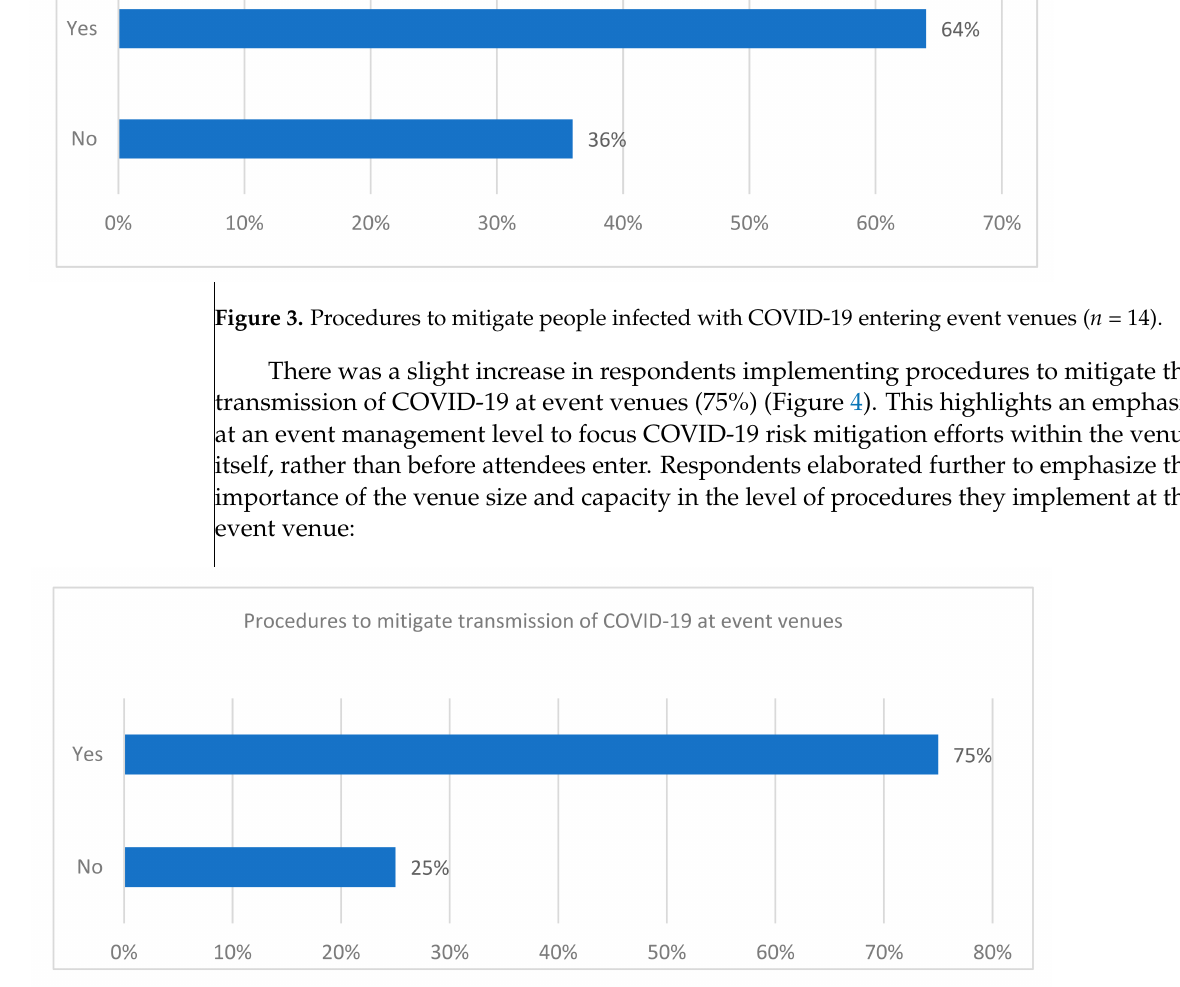
Figure 4. Procedures to mitigate the transmission of COVID-19 at event venues ( n =